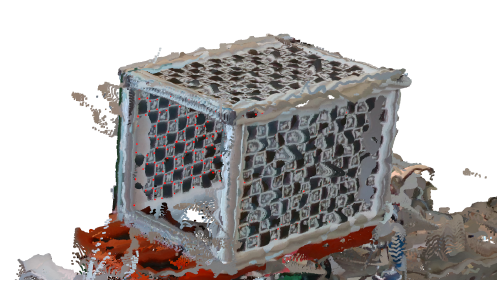
Figure 15. Reconstruction view using charuco double-sided angled